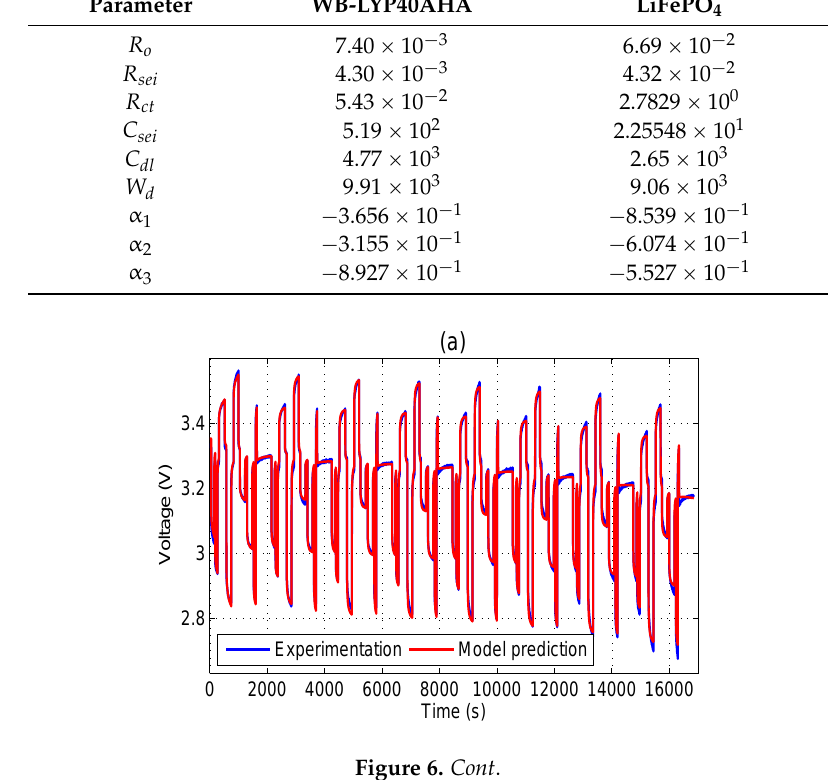
Table 2. Parameter identification results.